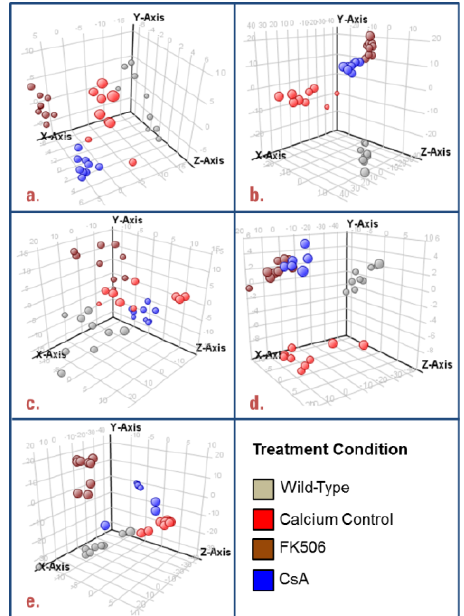
Figure 1. PCA plots for unannotated untargeted data mining features generated using data alignment, visualization and statistical analysis software. Clustering within each treatment condition ( n = 9), as well as separation between conditions was observed in each of the analytical conditions (( a ) reverse phase (RP)- electrospray ionization (ESI)+, ( b ) RP-ESI−, ( c ) aqueous normal phase (ANP)-ESI+, ( d ) ANP-ESI−, ( e ) RP-APCI+). CsA, Cyclosporin